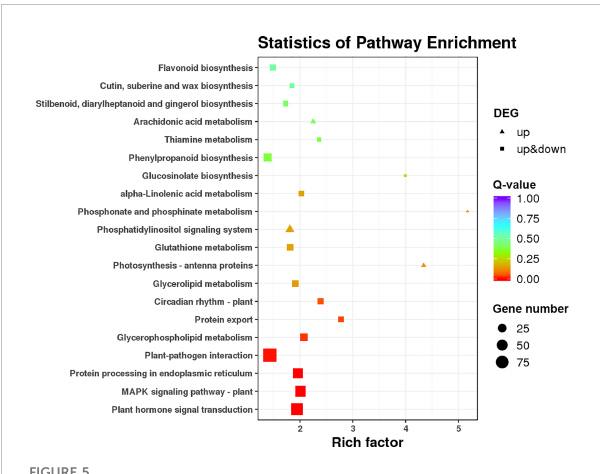
FIGURE 5 KEGG pathway enrichment for differently expressed genes.